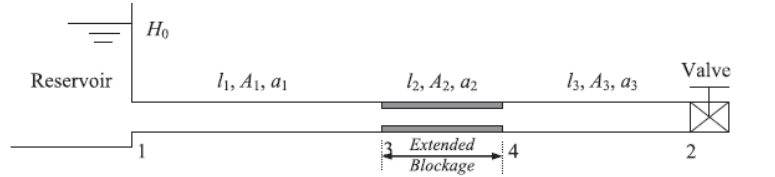
Figure 19. Pipeline with single extended blockage. Reprinted from Journal of Fluids and Structures, Volume 46, Duan, H.F.; Lee, P.J.; Ghidaoui, M.S.; Tuck, J. Transient Wave-blockage Interaction and Extended Blockage Detection in Elastic Water Pipelines, Page 2–16, Year 2014 with permission from Elsevier